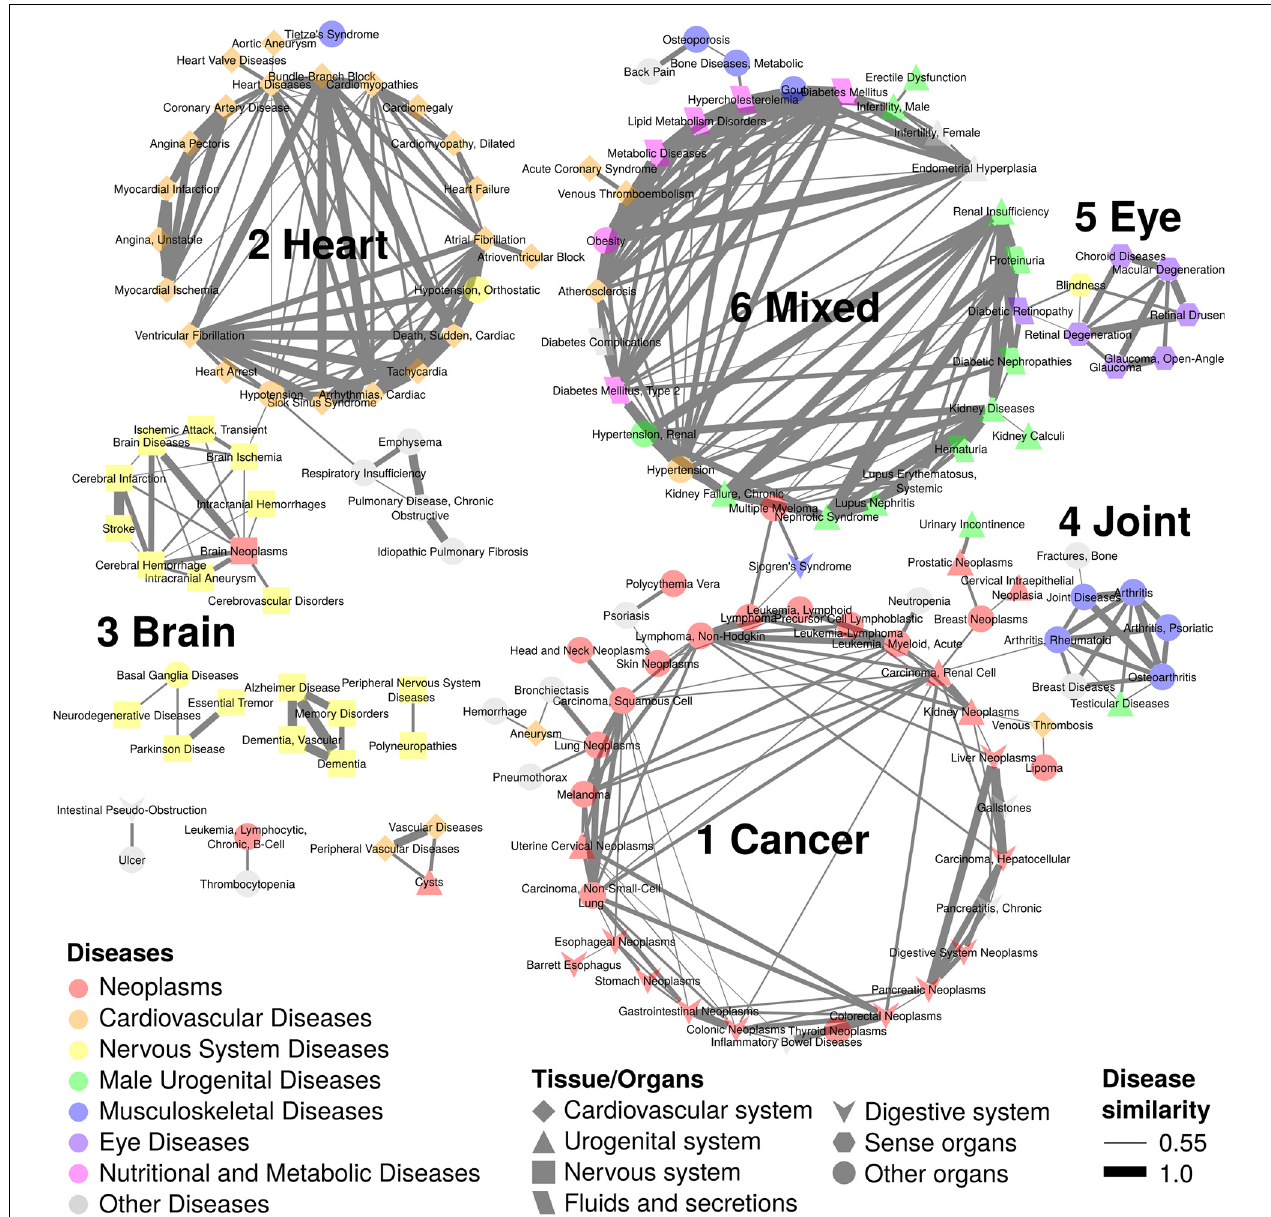
FIGURE 3 | Disease network of 144 ARDs with 6 subnetworks. The ARD subnetworks of disease pairs with similarity scores > 0.55 are shown. There are 6 subnetworks; subnetwork 1 with 41 ARDs is composed of cancers; subnetwork 2 with 24 ARDs includes heart diseases; subnetwork 3 with 10 ARDs is composed of brain diseases; subnetwork 4 with 8 ARDs includes joint diseases; subnetwork 5 with 7 ARDs is composed of eye diseases; and subnetwork 6 with 32 ARDs contains mixed diseases. Node colors indicate different disease types. Node shapes represent different tissue/organs. Edge thickness indicates disease similarity score, with the thickest edge representing a disease similarity score =